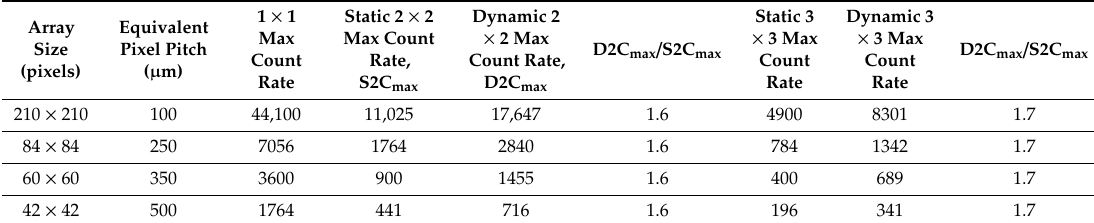
Table 3. The ratios of maximum count rates for dynamic and static of 2 × 2 and 3 × 3 CSCAs. Array Size